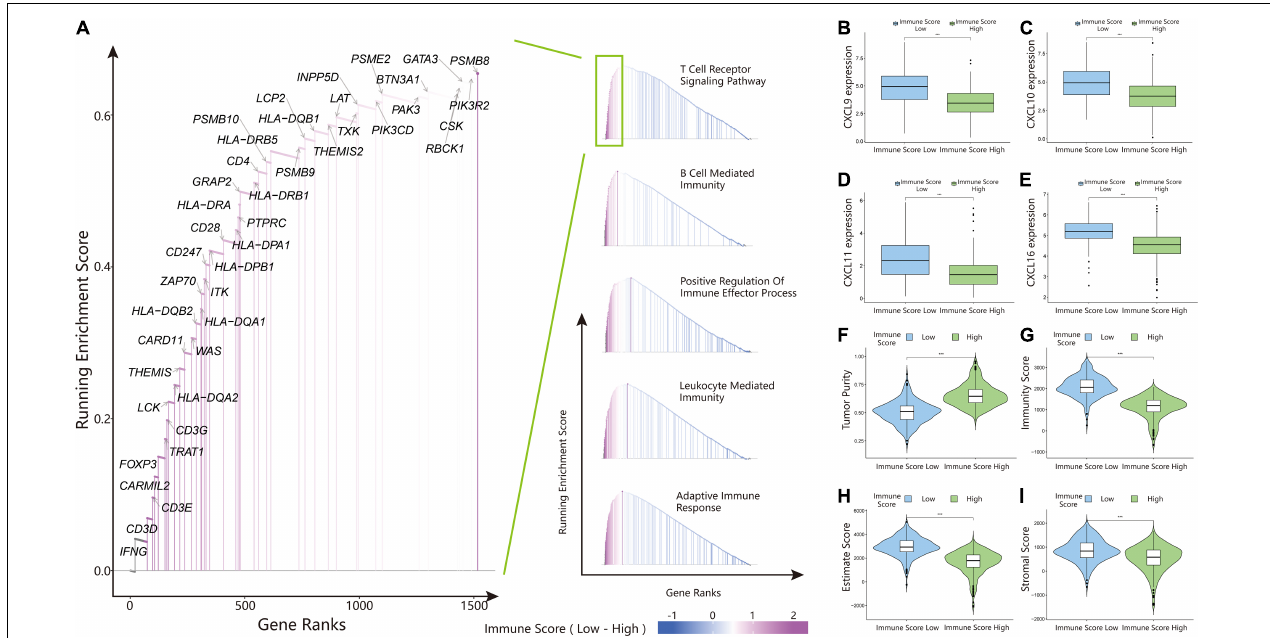
FIGURE 4 | Gene set enrichment analysis (GSEA), chemokine expression, and estimateScore results in the ISL and ISH groups. (A) Gene ontology (GO) enrichment analysis of the activation states of immune-related pathways in distinct immune score groups. (B–E) Expression of CXCL9/10/11/16 between the ISL and ISH groups. The upper and lower ends of the box indicate the interquartile range of values. The line in the box indicates the median value, and the black dot indicates the outlier. The asterisk indicates the statistical p -value (*** < 0.001). (F–I) Violin plot of the estimateScore between the ISL and ISH groups, including the tumor purity (F) , immunity score (G) , estimate score (H) and stromal score (I) . The asterisk indicates the statistical p -value (*** <